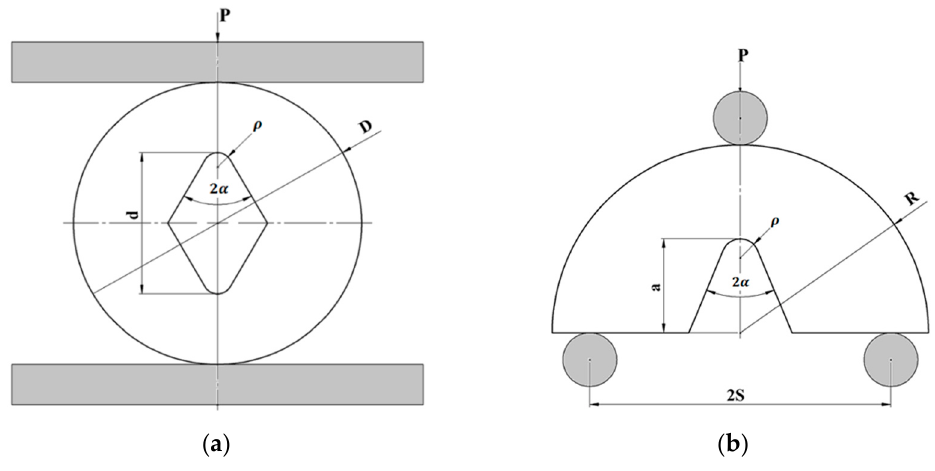
Figure 1. Schematics of the fracture samples: ( a ) RVNBD; ( b ) RVNSCB. Since the fracture toughness K Ic of PMMA and GPPS materials must be specified for calculating the FPZ length, several cracked Brazilian disk (CBD) and semi-circular bend (SCB) specimens were prepared and tested. The CBD and SCB specimens are similar to the RVNBD and RVSCB samples, except that a sharp crack of length 2a for CBD and length a for SCB is generated in the center of the sample instead of in the rhombic hole and other configurations remain constant. Table 1 gathers the dimensions and loading conditions for all samples. Table 1. The dimensions and loading conditions for all specimens (all values in mm).